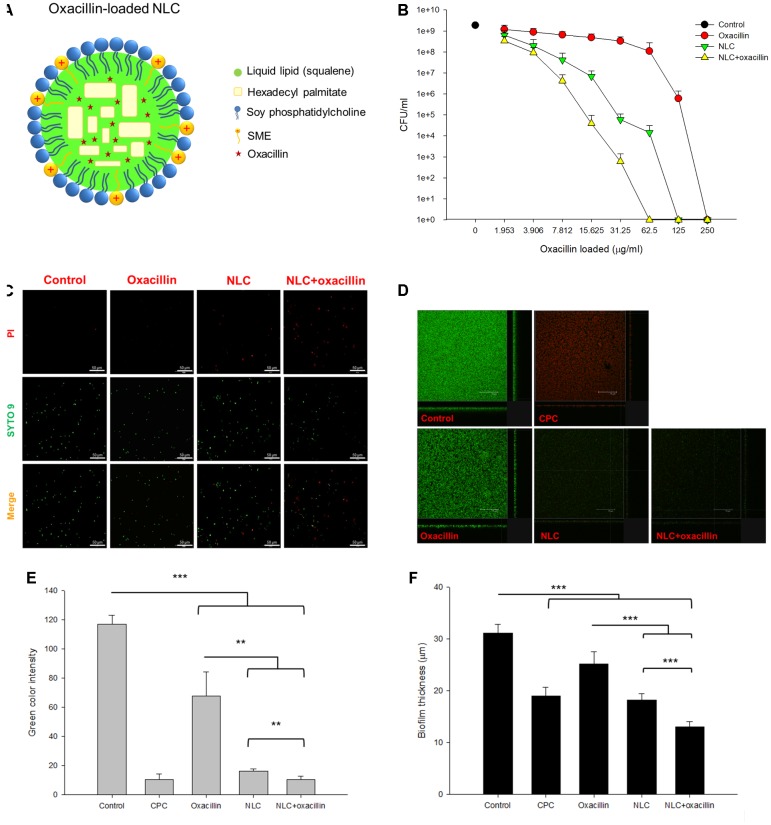
Determination of the anti-MRSA activity of oxacillin and/or NLC. (A) The proposed structure of oxacillin-loaded NLC: oxacillin is included in the lipid matrix, whereas SME is intercalated in the emulsifier layers. (B) Dose-dependent MRSA killing measured by CFU. (C) The planktonic live/dead MRSA strain viewed under fluorescence microscopy. (D) The three-dimensional images viewed under confocal microscopy. (E) Quantification of fluorescence intensity of MRSA biofilm. (F) The corresponding biofilm thickness analyzed by confocal microscopy. Each value represents the mean ± SD (n = 3). ∗∗p < 0.01 and ∗∗∗p < 0.001.